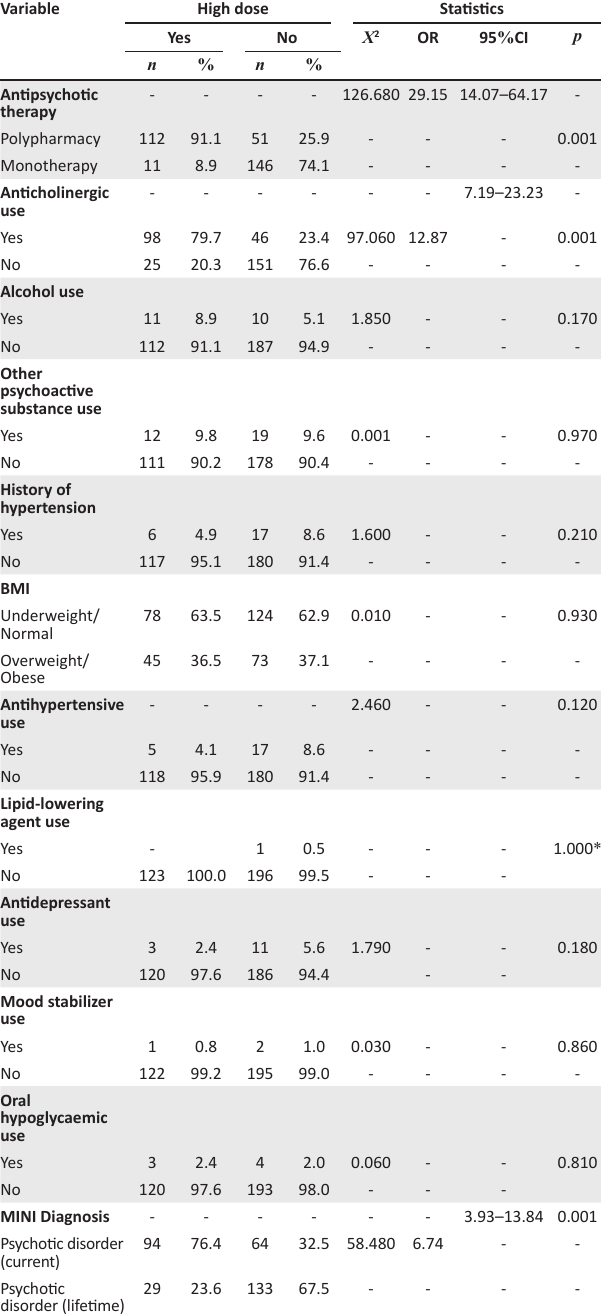
TABLE 4: Comparison of clinical related characteristics of participants and high dose prescribing. Variable High dose